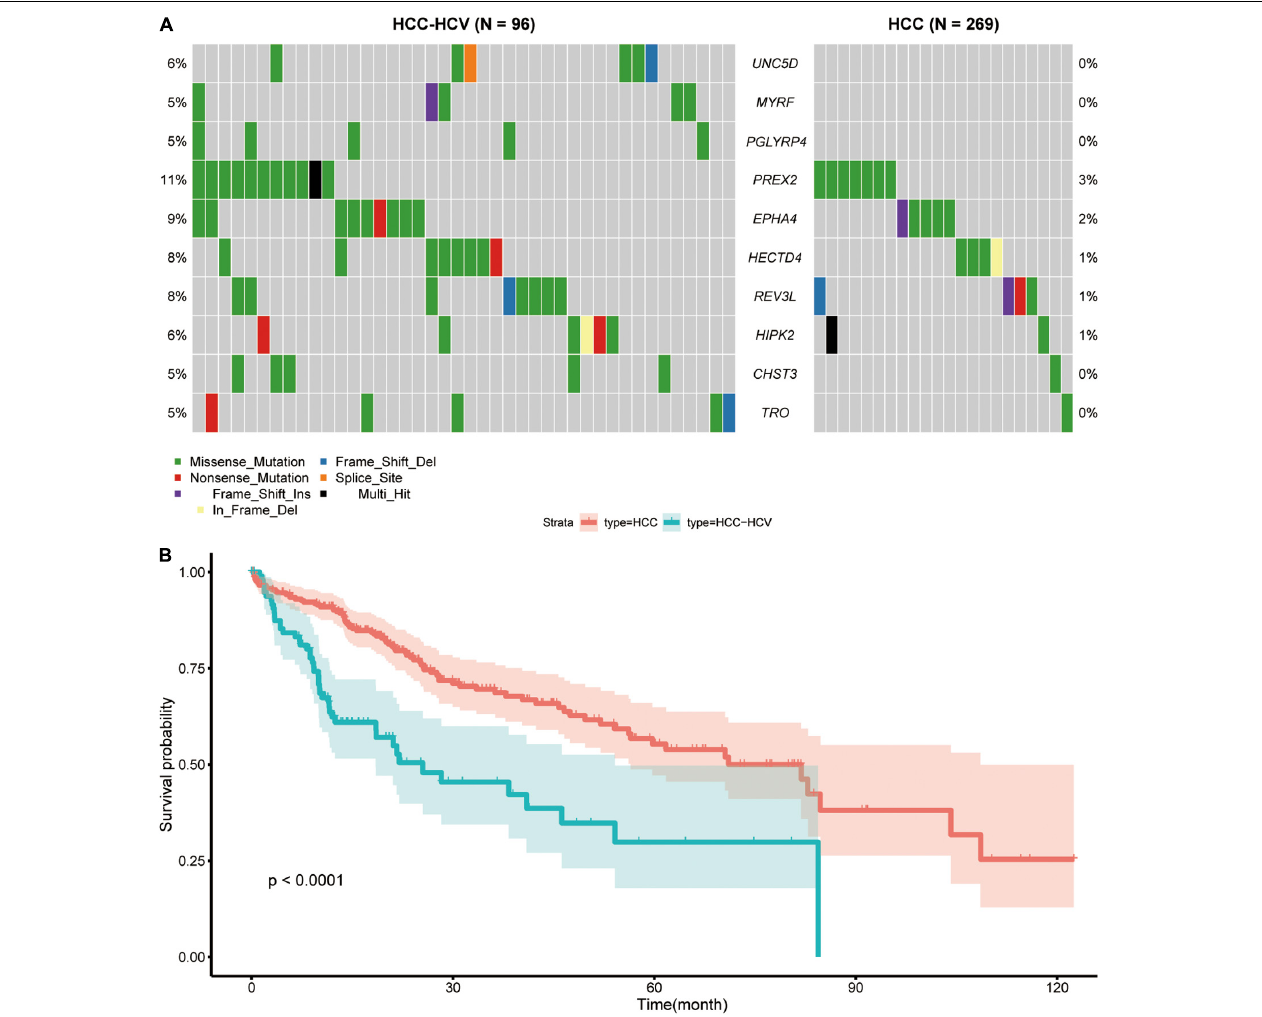
FIGURE 2 | Analyses of different somatic mutations and survival time in HCC-HCV and HCC samples. (A) Waterfall plot of detailed information of top 10 differentially mutated genes in each group. (B) K-M curves of patients in the HCC group and HCC-HCV group. HCC, hepatocellular carcinoma; HCV, hepatitis C virus; K-M,